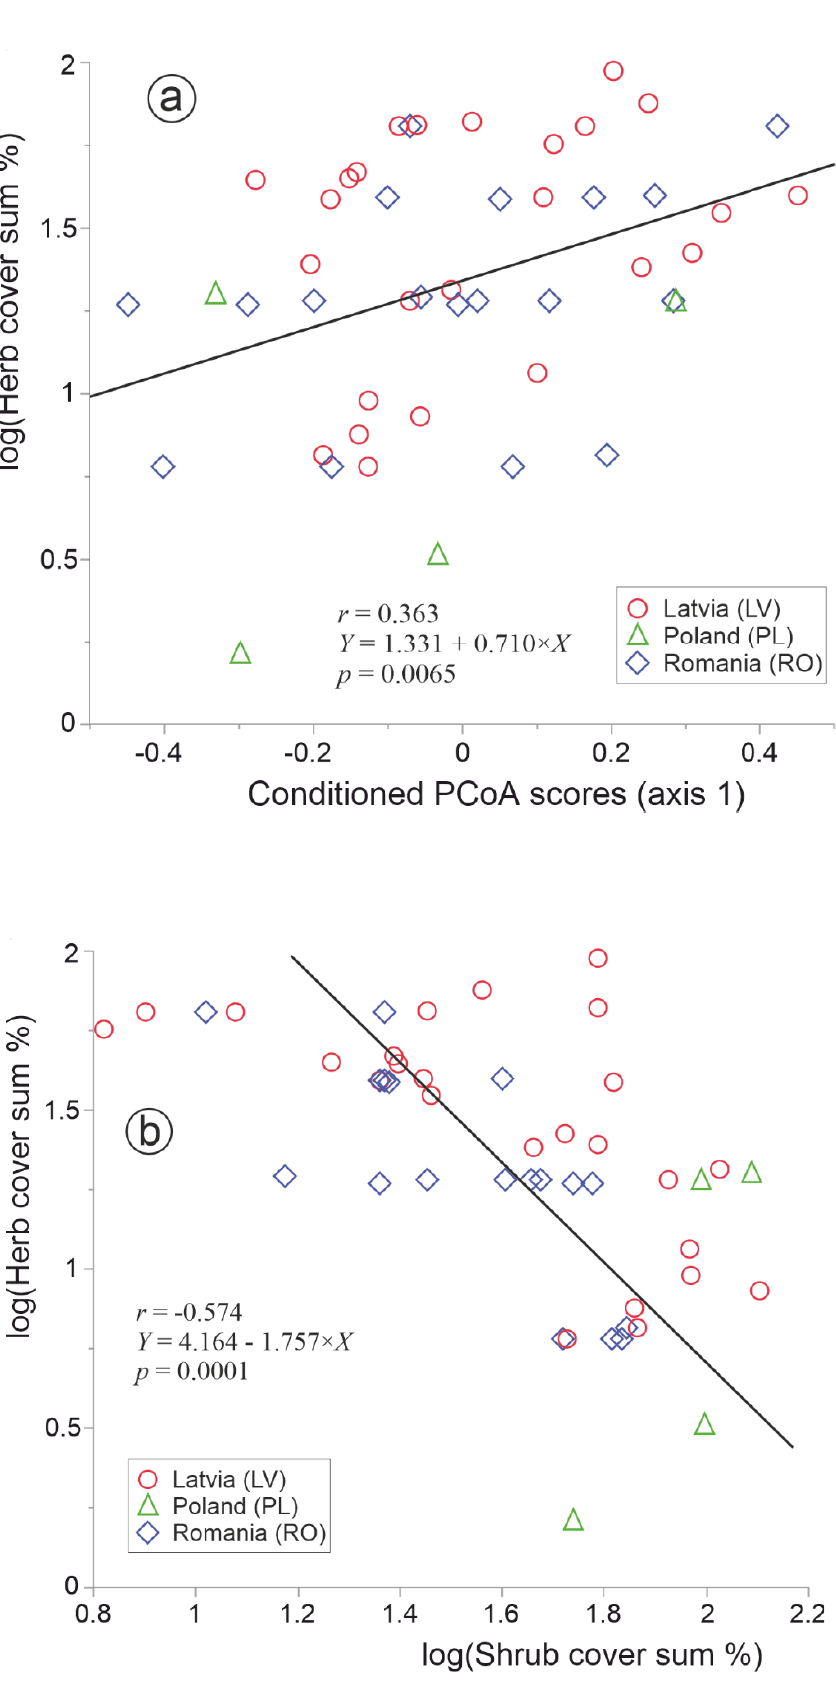
Figure 4. Model II linear regressions of the herb cover sum against (a) the relevé scores on the conditioned PCoA axis 1 and (b) the shrub cover sum,